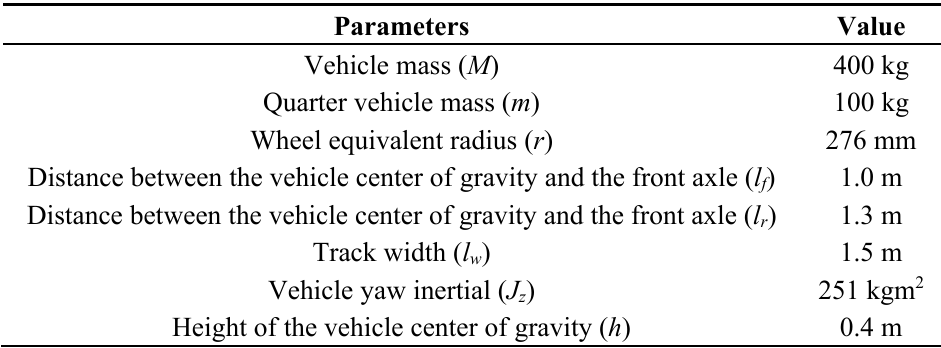
Table 1. Vehicle parameters of the simulation.